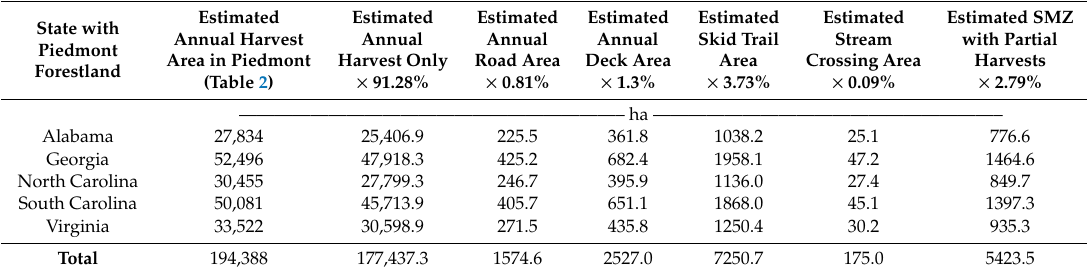
Table 3. Estimated area within each state and operational area for the Piedmont region based on the average percentage for each operation by Barrett et al. [38].